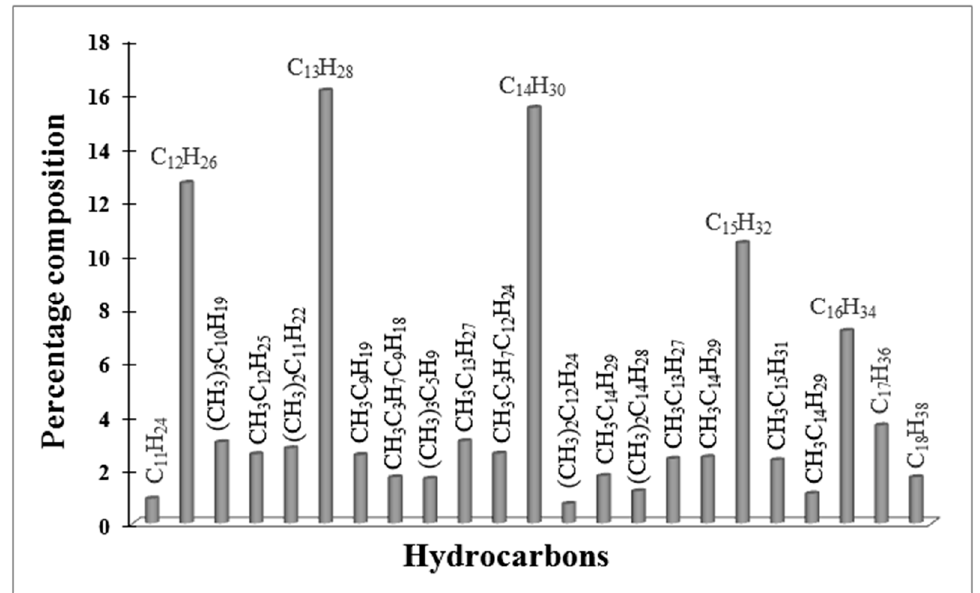
Figure 11. GC- MS analysis of liquid products obtained in FTS on Red-C-Co 5.0 SiBEA catalyst reduced at 900 °C in 5% H 2 -95% Ar flow.